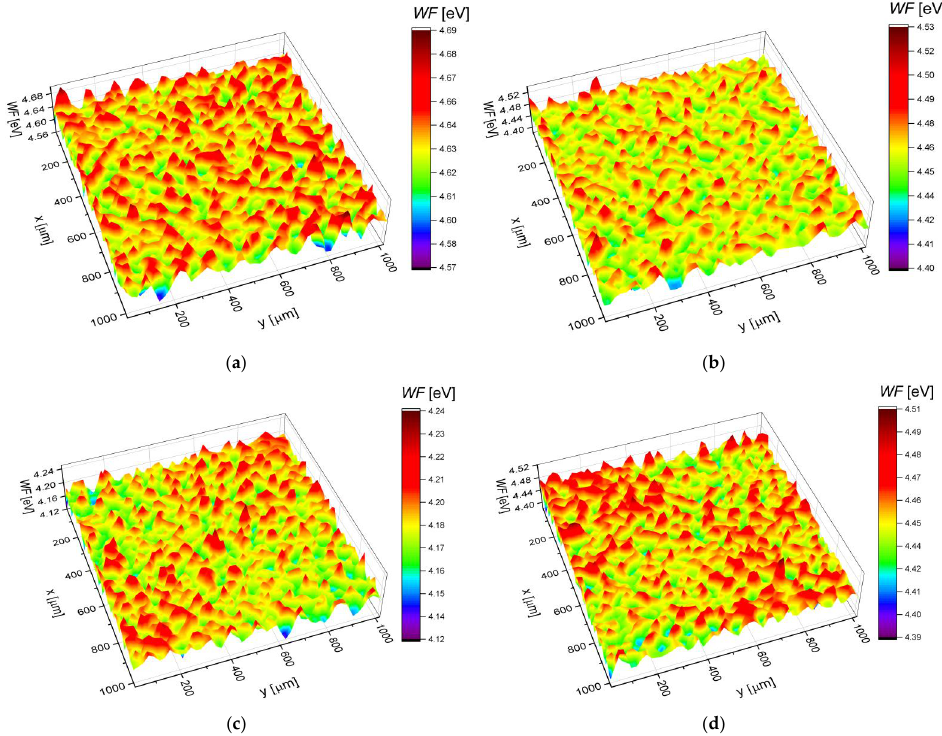
Figure 3. Work function maps determined for as-deposited electrodes: ( a ) Pd; ( b ) Pd-Rh; ( c ) Pd-Ru; ( d ) Pd-Pt.